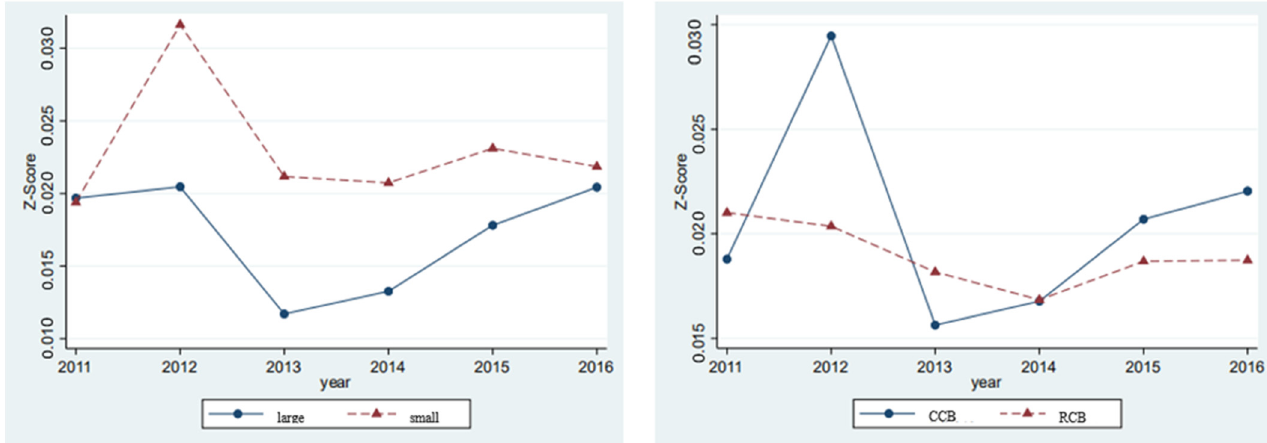
Figure 2. Z-Score trend of different types of bank risks. Software: MATLAB.